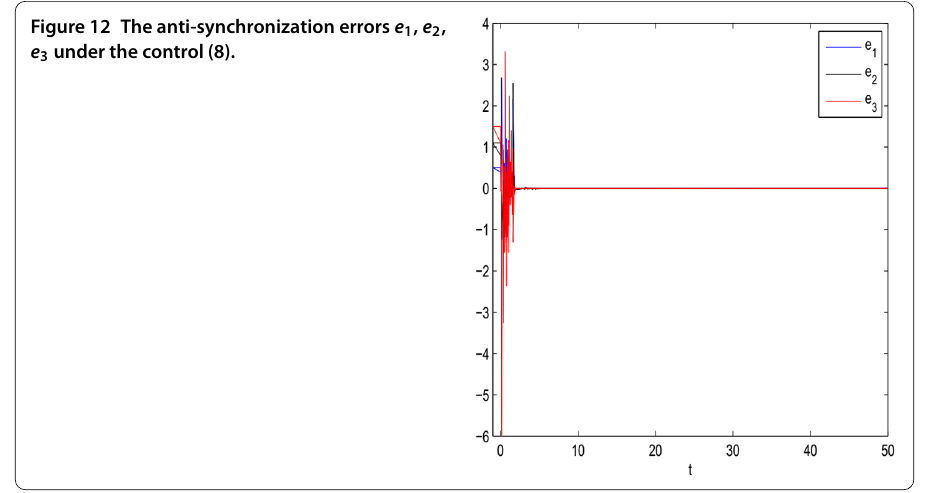
Figure 12 The anti-synchronization errors e 1 , e 2 , e 3 under the control (8).